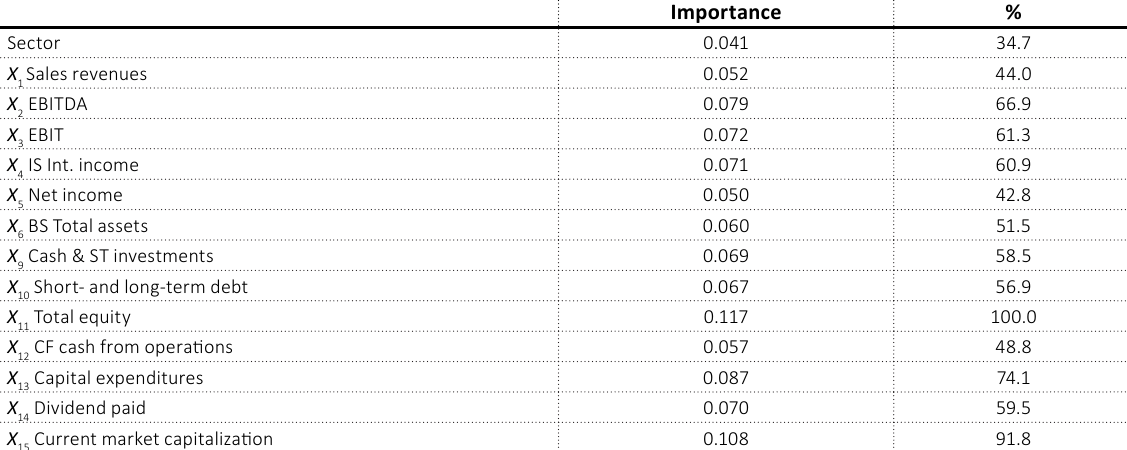
Table 17. Importance and relative importance of the input